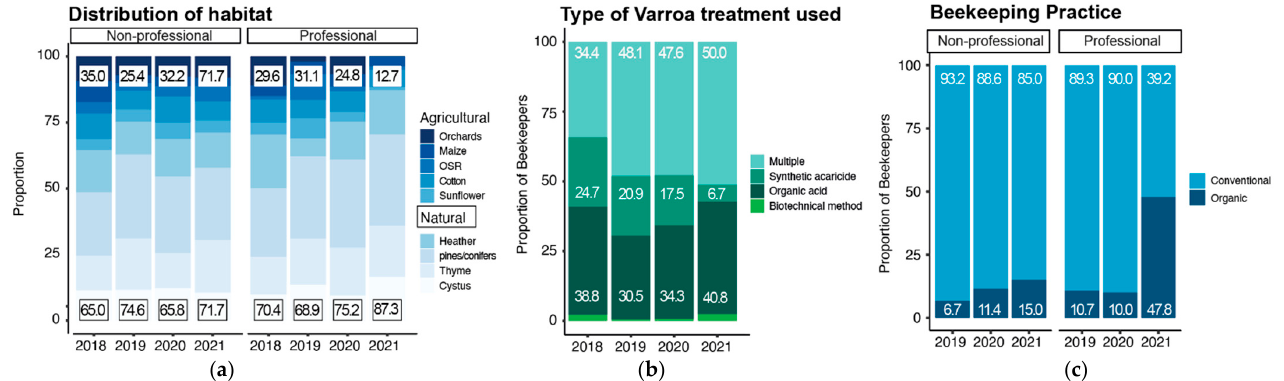
Figure 4. Decreases in chemical usage and evidence for a transition toward organic beekeeping: ( a ) bar plot showing the distribution of agricultural and natural plants visited for honey production with their respective percentage per year and according to their profession; ( b ) stack bar plots showing the proportion of acaricide usage across the four years; respective percentage for biotechnical method are 2018: 2.1%, 2019: 0.5%, 2020: 0.6% 2021: 2.5%. ( c ) Bar plots showing the distribution of beekeeper declarations in relation to their beekeeping practice, according to their profession, and across the years.